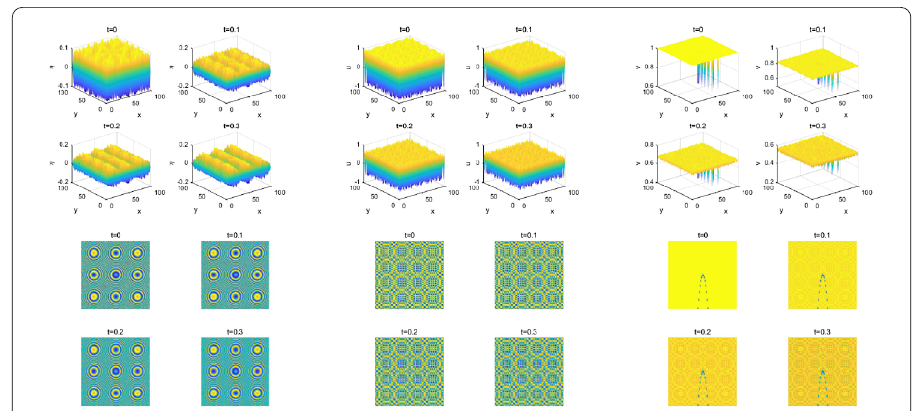
Figure 8 Numerical solution and pattern of Experiment 3, for initial conditions see Table 3